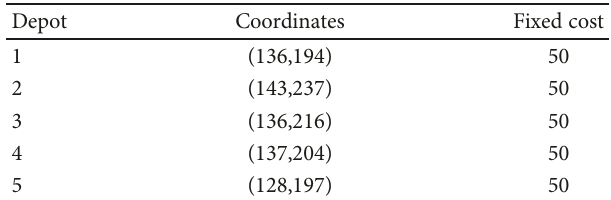
Table 2: Gaskell67-21 × 5 (HDCC).